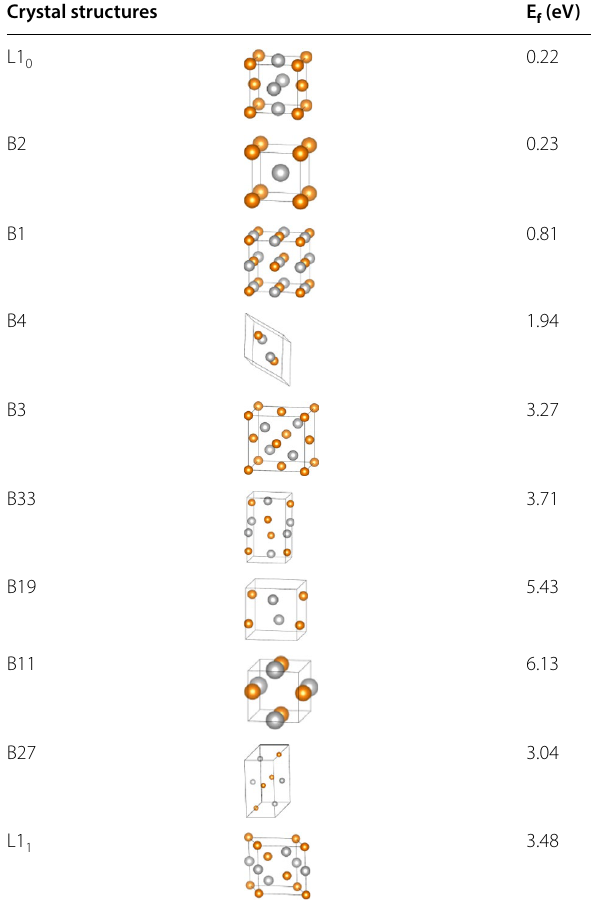
Cu atom: orange color, Ag atom: grey color